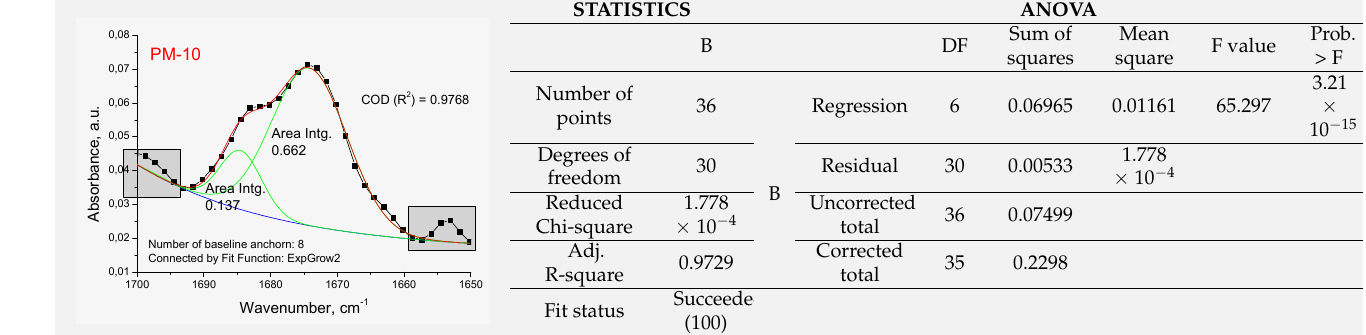
Table A3. Sample P-15.